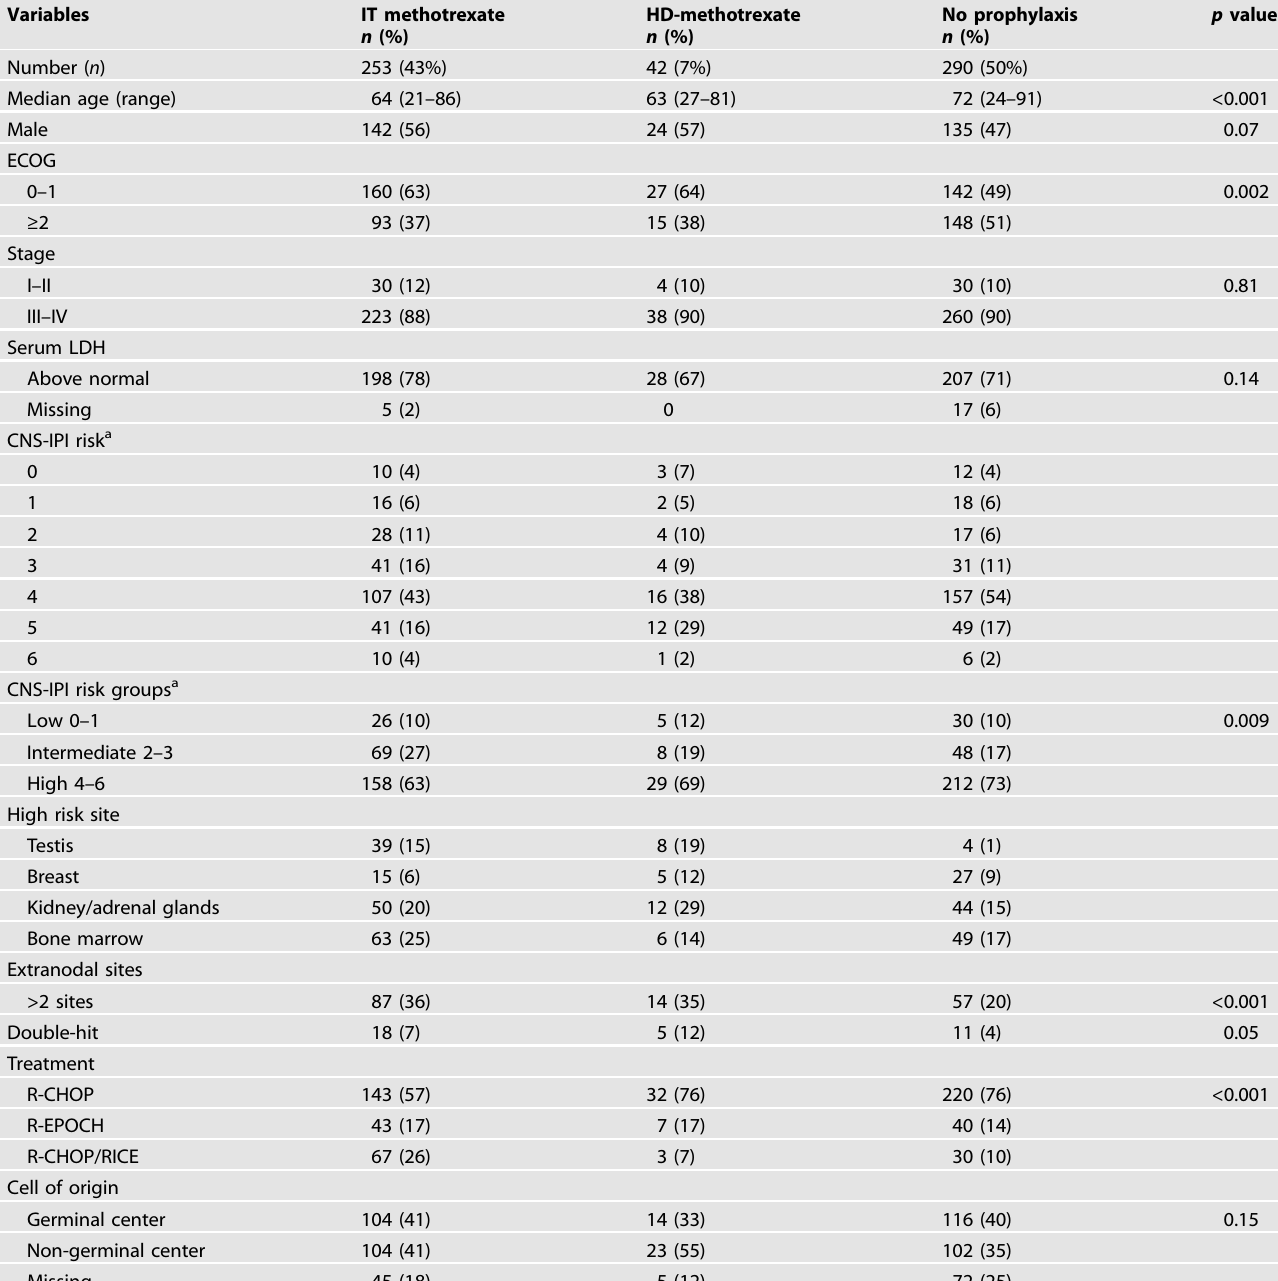
Table 1. Patient ’ s